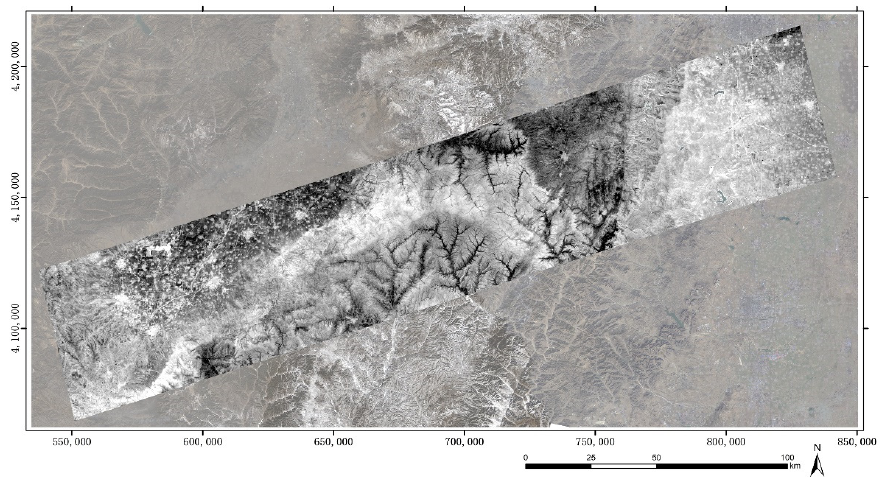
Figure 8. The orthorectification result of SDASAT-1 TIS image overlayed with the visible reference image. (UTM, 49